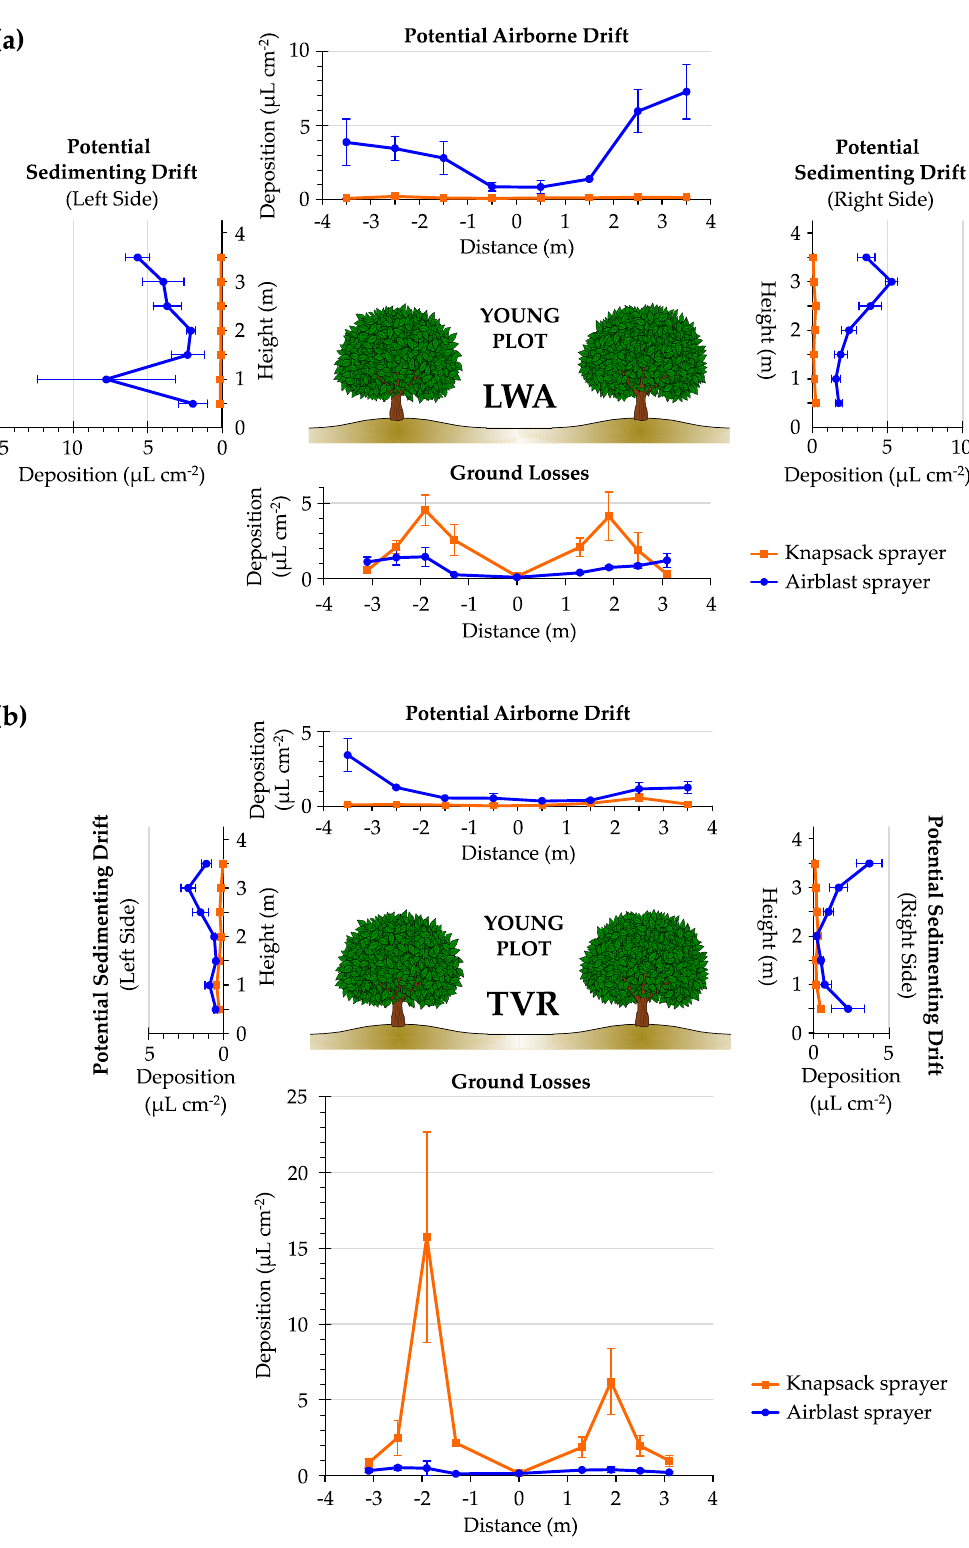
Figure A4. Off-target losses (mean (s.e.), μ L cm − 2 ) with the knapsack and the air-blast sprayer in the Figure A4. O ff -target losses (mean (s.e.), µ L cm − 2 ) with the knapsack and the air-blast sprayer in the young plot and with dose expression using ( a ) LWA and ( b ) TRV. young plot and with dose expression using ( a ) LWA and ( b )